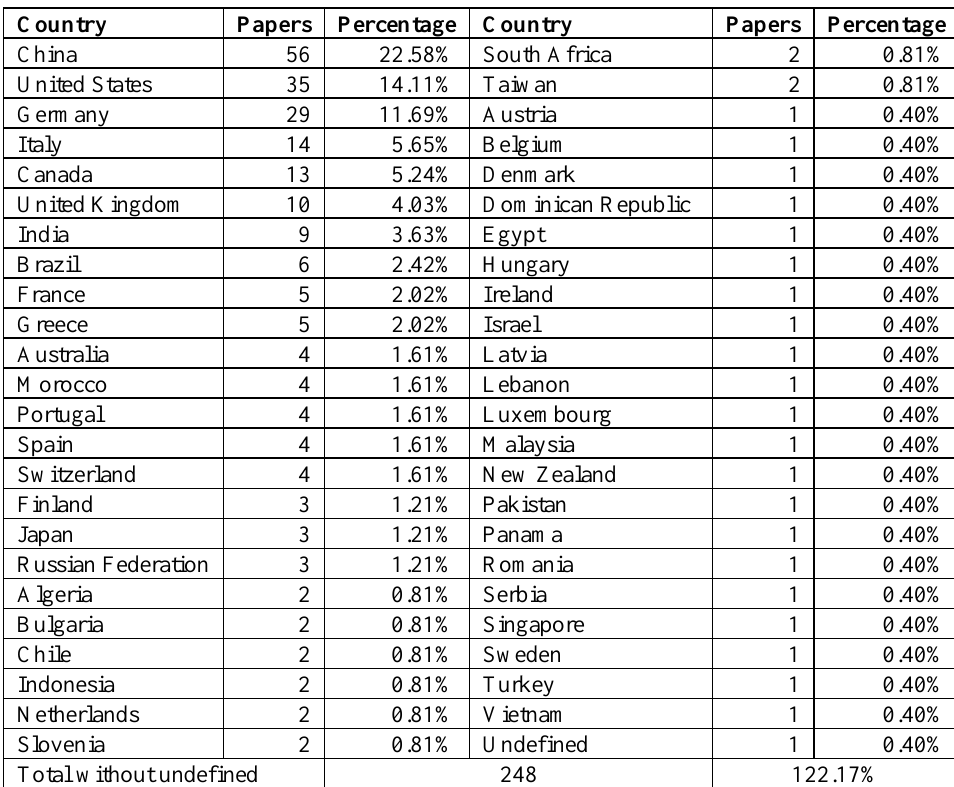
Table 9. Distribution of publications by country